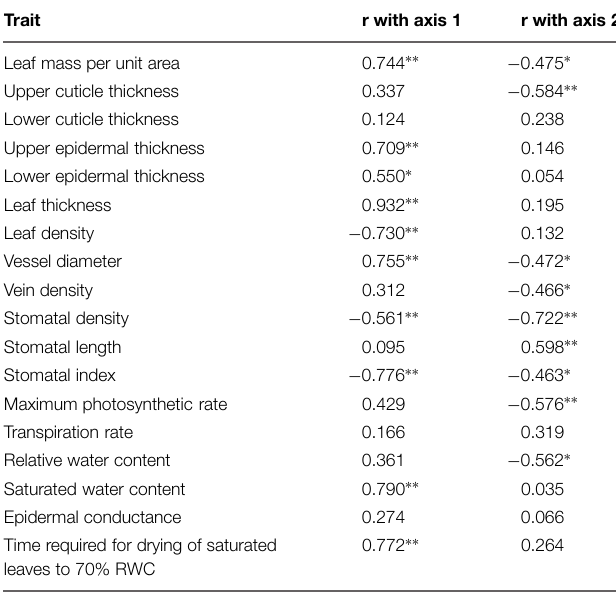
TABLE 3 | Correlations (r) of leaf traits with principal component analysis (PCA) axes 1 and 2. Trait r with axis 1 r with axis